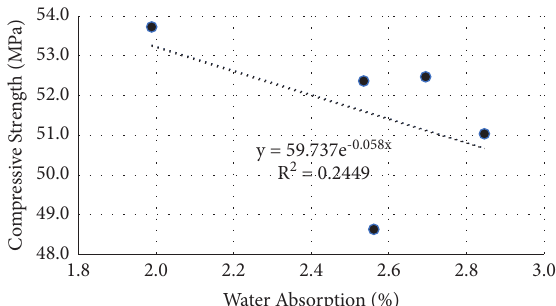
Figure 21: Fitted line plots of regression analysis for the rela- tionship between compressive strength and water absorption.